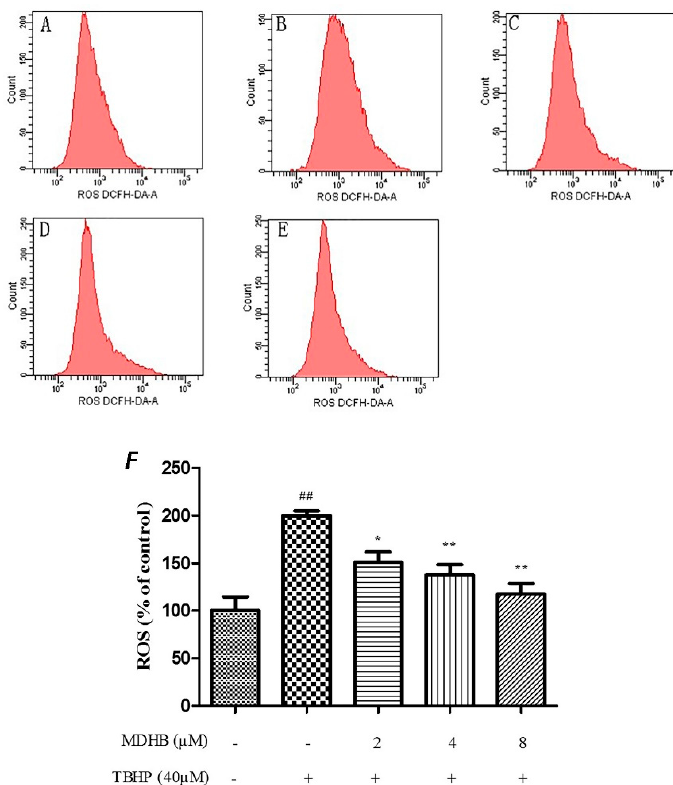
Figure 4. Effect of MDHB on TBHP-induced ROS accumulation in SH-SY5Y cells. SH-SY5Y cells were treated with MDHB (2, 4, or 8 µ M) for 4 h before exposure to 40 µ M TBHP for another 24 h.